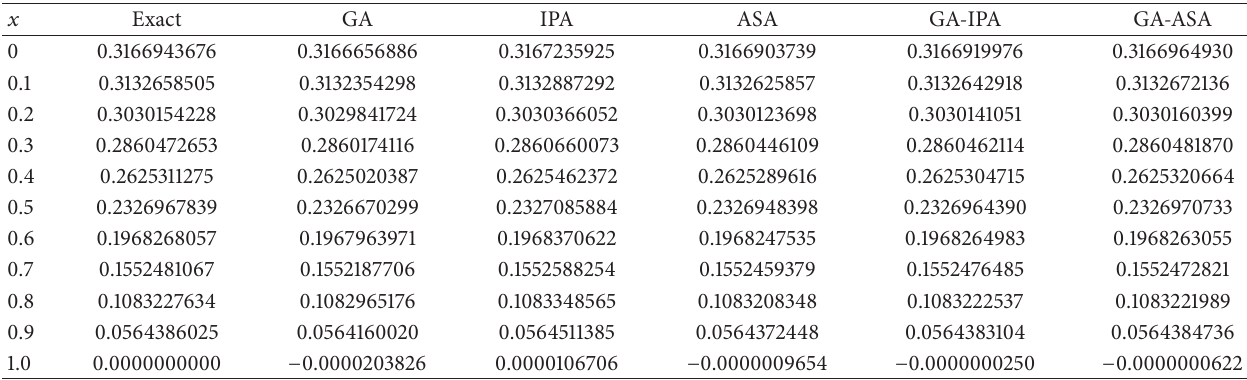
Table 3: Numerical results of Example 1 by the proposed method.